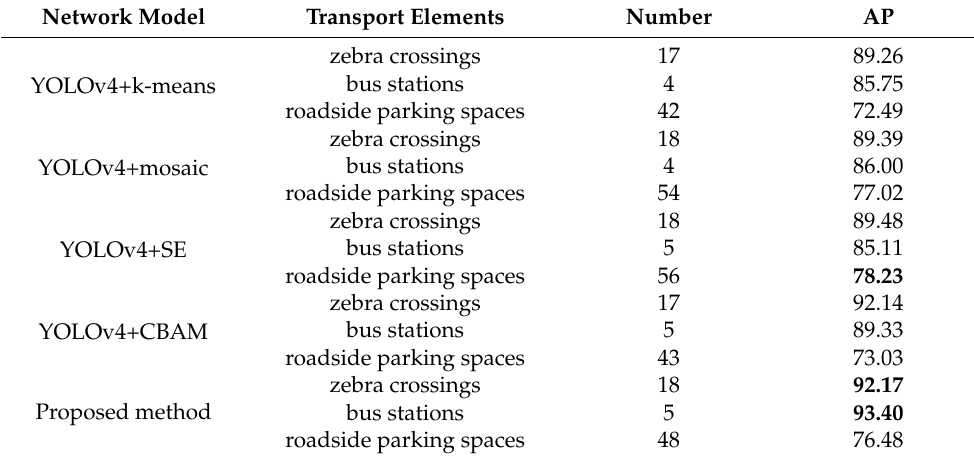
Table 5. Predicted results of ablation experiments in large complex